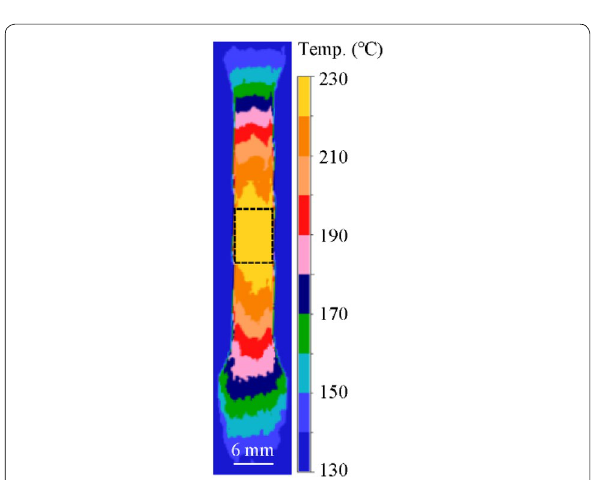
Figure 3 Temperature contours of an induction-heated specimen in uniaxial tensile testing at 230 °C